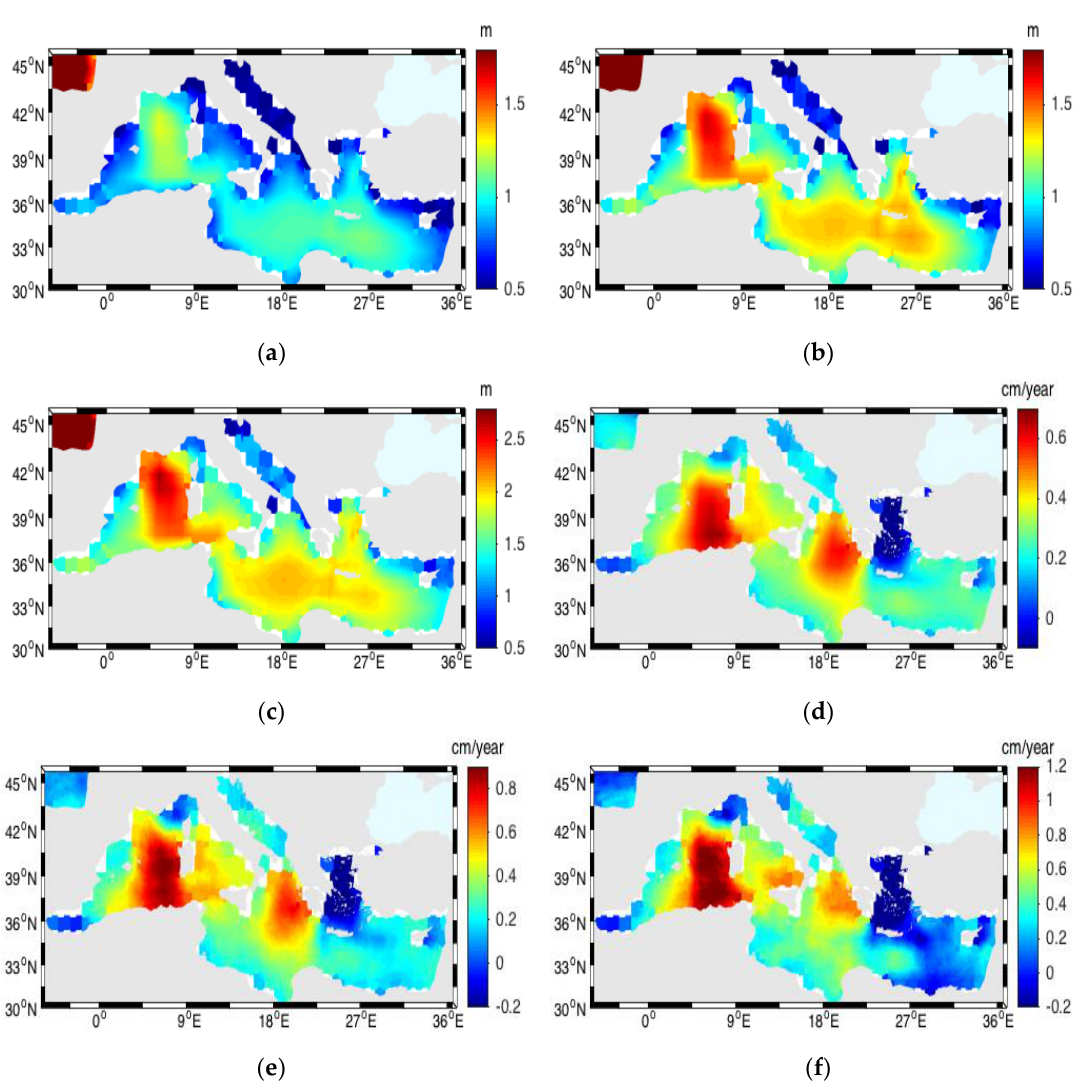
Figure 8. Significant wave heights (SWH): ( a ) 36-year mean SWH; ( b ) 36-year averaged annual 75th percentiles; ( c ) 36-year averaged annual 90th percentiles; ( d ) trends in the mean annual SWH; ( e ) trends in the 75th percentiles, ( f ) trends in the 90th percentiles. Maps are based on the ERA Interim data (1982 – 2017).